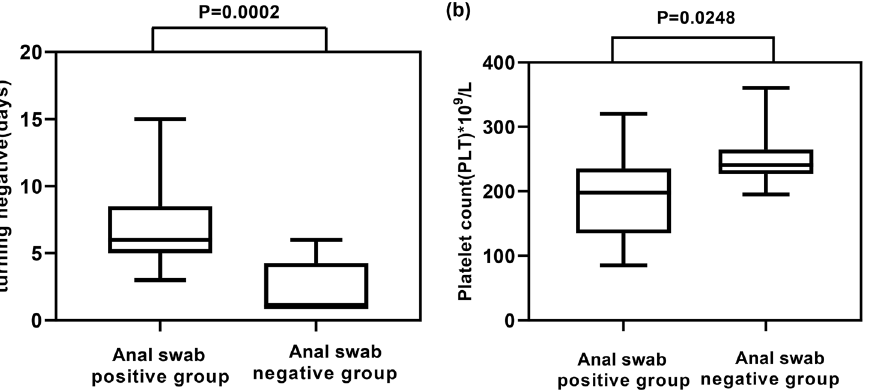
Figure 1: Comparison of time of pharyngeal swab turning negative and platelet counts between anal swab positive group and anal swab negative group. ( a ) Time of pharyngeal swab turning negative ( days ) . ( b ) Platelet counts.